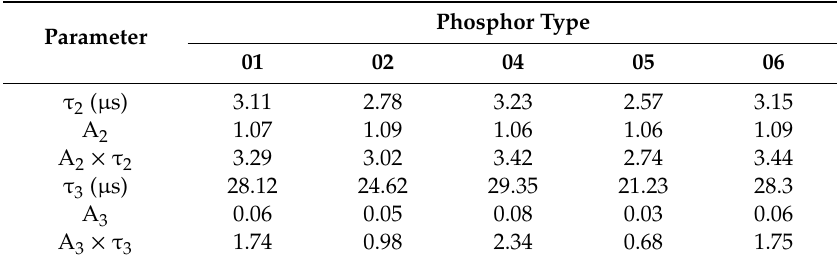
Table 4. Decay time ( τ i ), amplitude (A i ), and light sum (A i × τ i ) of slow components of the CL kinetics in the visible spectral region in C-YAG phosphors at 300